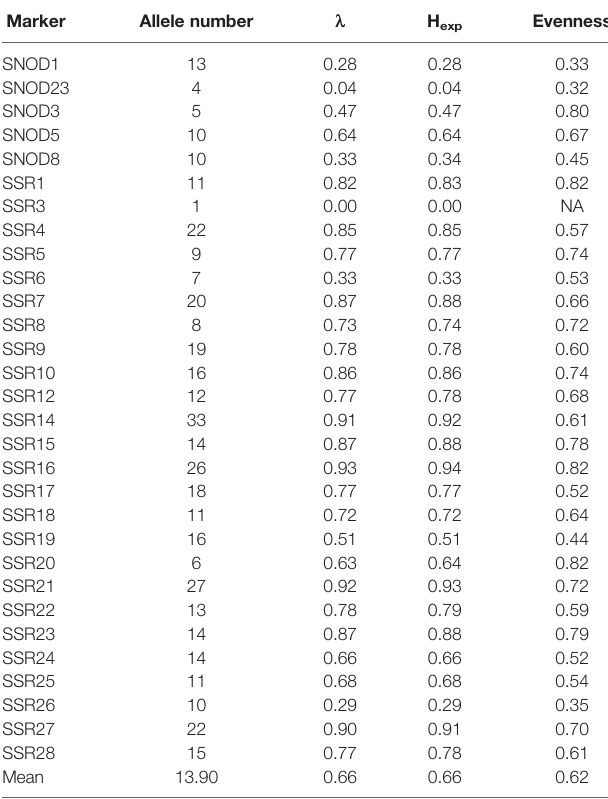
TABLE 1 | Number of alleles detected, l index, H exp , and evenness for each SSR marker. Marker